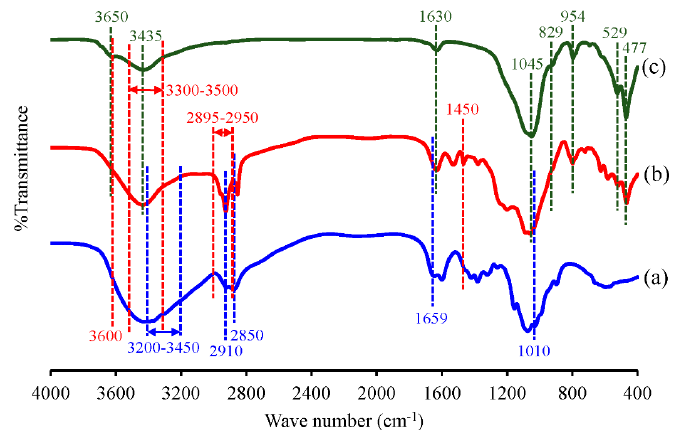
Figure 1. Representative Fourier transform-infrared spectrometry (FT-IR) spectrum of ( a ) chitosan, ( b ) montmorillonite chitosan composite (MCC) and ( c ) montmorillonite (Mt)-rich clay.